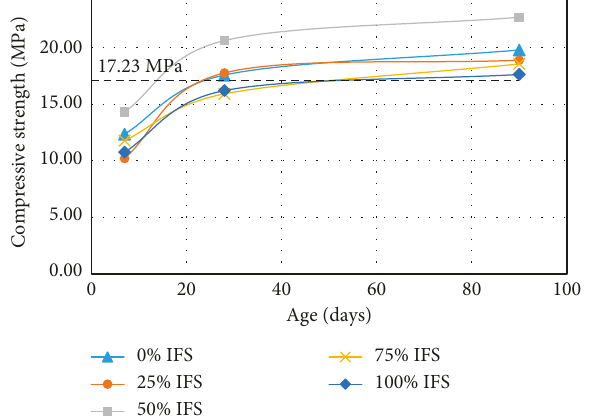
Figure 12: Compressive strength with days for different IFS ratio (target strength: 17.23MPa).